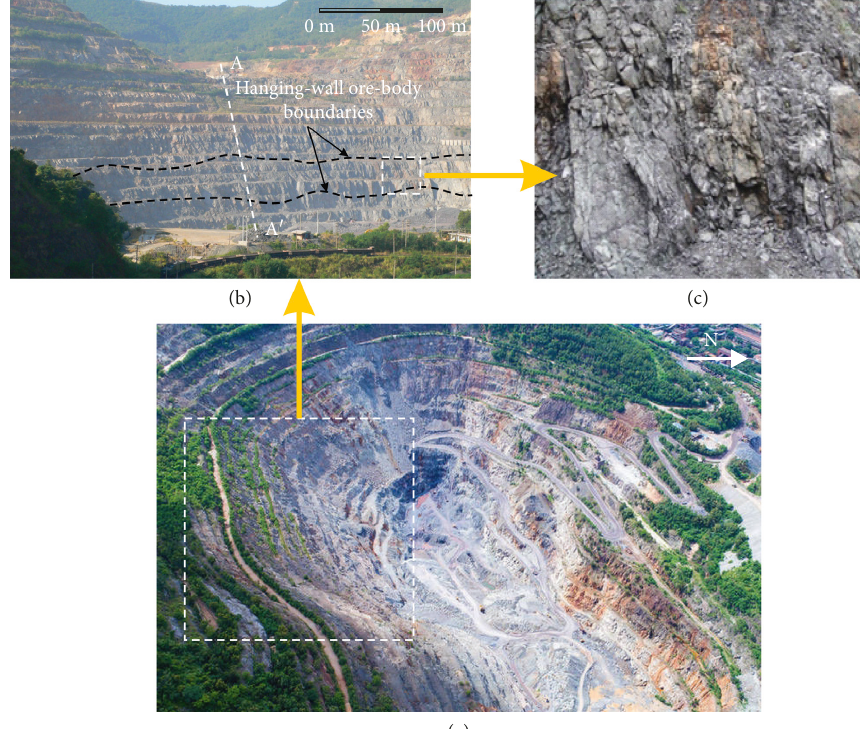
Figure 11: Production condition of the open pit. (a) Aerial view, (b) south slope with the sectional view shown in Figure 4(b), and (c) broken